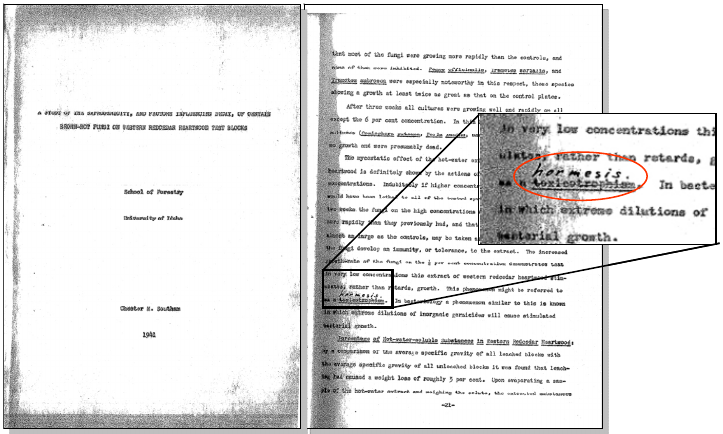
Figure 1. The first appearance of the term “hormesis” can be traced back to 1941 in the undergraduate thesis of Chester Southam as a better substitution for the word “toxicotrophism”. There, he reported that low doses of the toxic red cedar tree extract enhanced the proliferation of fungi with an overall biphasic shape of the dose response (credit: